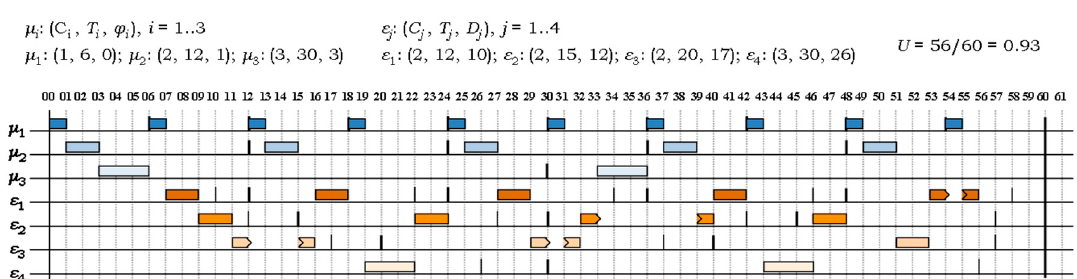
Figure 2. H 2 RTS scheduling of a system of N = 7 hard real-time tasks.